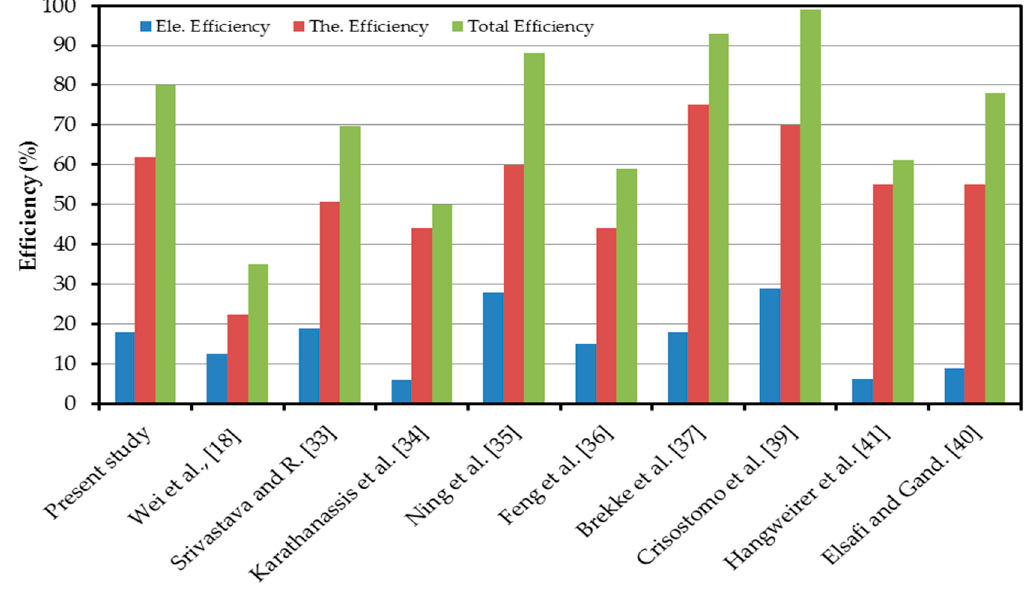
Figure 25. Comparison of CPVT system efficiency of the present study against different studies.